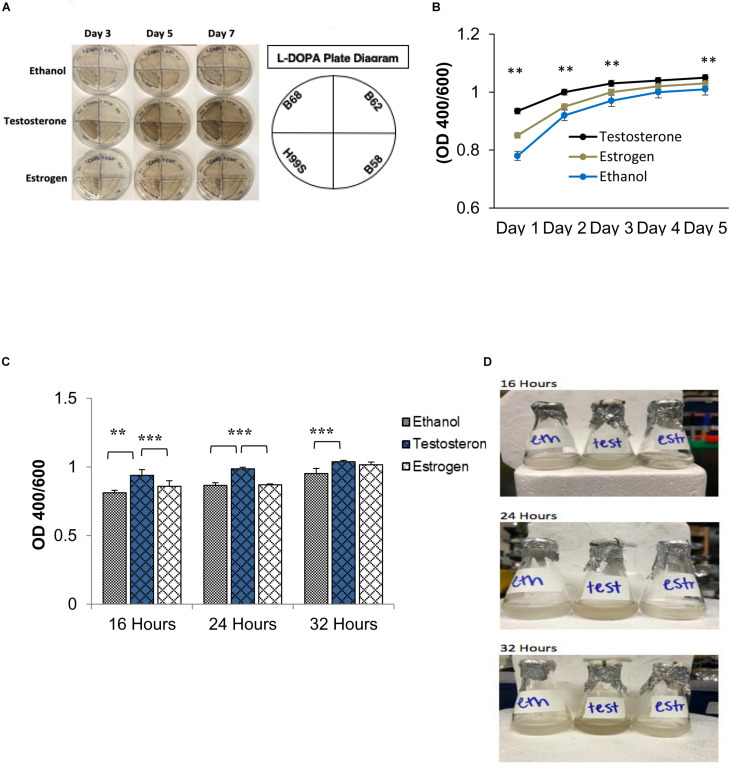
Melanization of C. neoformans on L-3,4-dihydroxyphenylalanine (L-DOPA) agar plates and liquid medium in the presence of steroid hormones (estradiol, 400 pg/mL; testosterone, 10 ng/mL). (A) Melanization of C. neoformans clinical isolates grown for 7 days on L-DOPA agar plates supplemented with steroid hormones. Images were taken on days three, five, and seven. (B) Melanization of H99S grown for 5 days in L-DOPA medium supplemented with steroid hormones and measured at an optical density of 400 and 600 nm. Data is representative of three independent experiments. Statistical significance is represented as follows: ∗∗p < 0.001 comparing testosterone to ethanol and estradiol, using linear regression analysis. (C) Melanization of C. neoformans in conditioned media supplemented with steroid hormones. Absorbances were measured at an optical density of 400 and 600 nm. Error bars represent the standard deviation. Data is representative of three independent experiments. Statistical significance is represented as follows: ∗∗p < 0.002, ∗∗∗p < 0.0002 using MANOVA with simple contrasts, comparing testosterone to estrogen or ethanol. (D) Pictures of H99S melanized cells from (C) at 16, 24, and 32 h. Test, Testosterone; Estr, Estrogen (Estradiol); Eth, Ethanol.